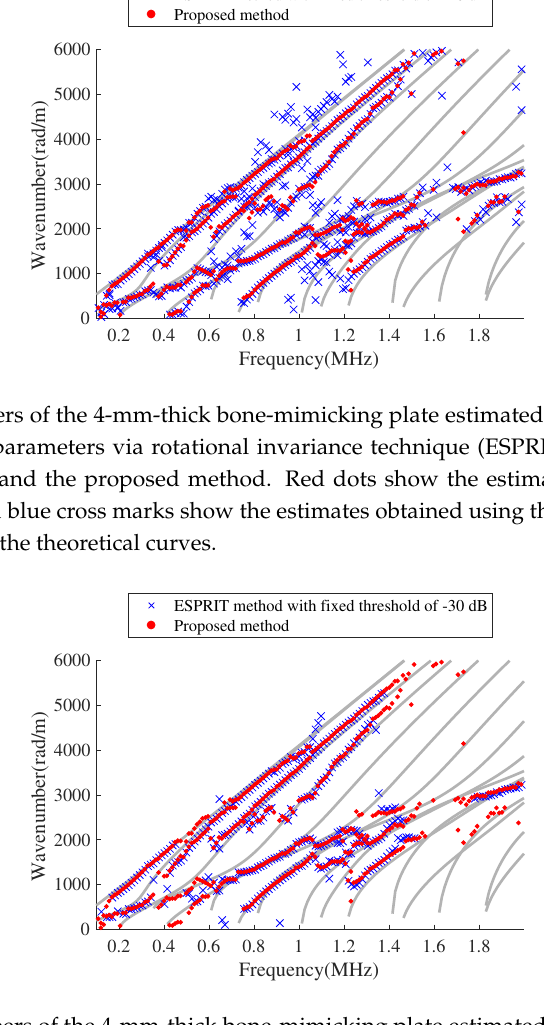
Figure 10. Wavenumbers of the 4-mm-thick bone-mimicking plate estimated using the conventional ESPRIT algorithm at a fixed threshold of − 30 dB and the proposed method. Red dots show the estimates obtained using the proposed method and blue cross marks show the estimates obtained using the conventional method. Solid gray lines show the theoretical